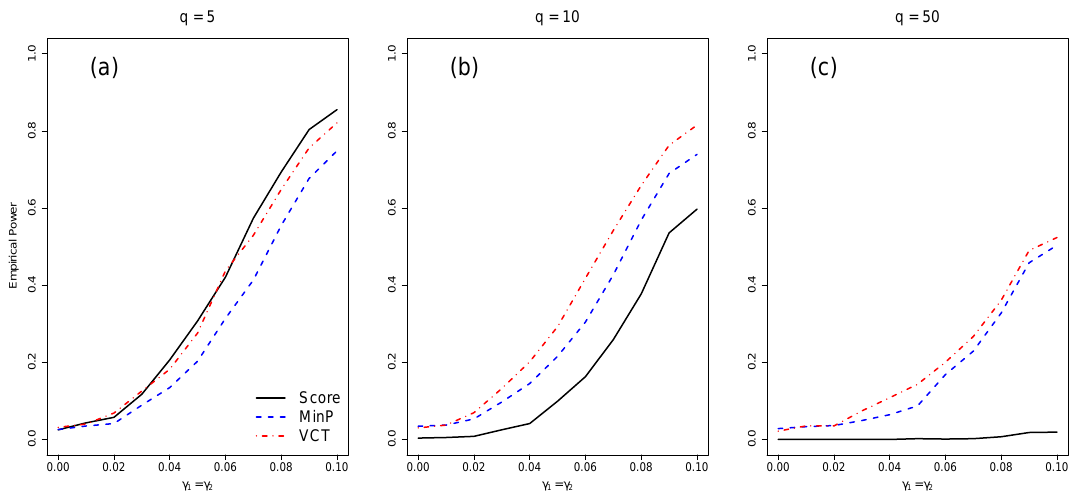
Figure 4. Empirical power at 0.05 α -level of the methods for q correlated SNPs of which two of the SNPs have a main effect. The same two SNPs have an equal interaction with the environment. ( a ) q = 5 correlated SNPs; ( b ) q = 10 correlated SNPs; ( c ) q = 50 correlated